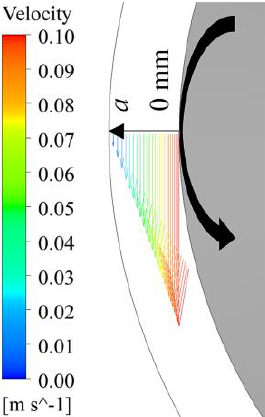
Fig. 12. The oil flow velocity profile in the gap for the spindle speed s 2 = 110 min -1